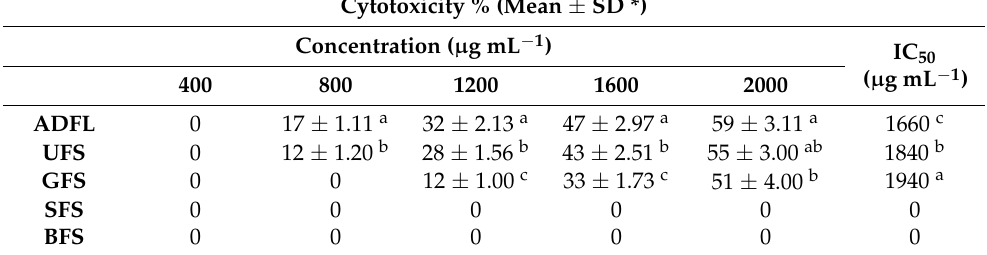
Table 4. Anti-proliferative activity (%) and IC 50 ( µ g mL − 1 ) values of ethanolic crude extracts of air-dried fenugreek leaves (ADFL), untreated fenugreek seeds (UFS), germinated fenugreek seeds (GFS), soaked fenugreek seeds (SFS), and boiled fenugreek seeds (BFS) against normal human kidney cell line